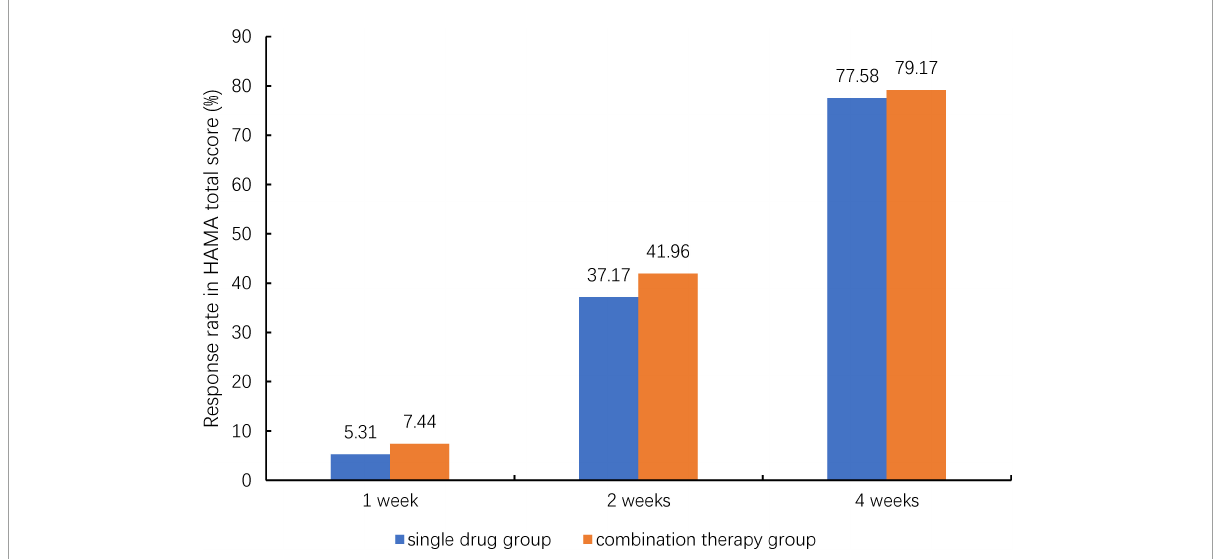
FIGURE2 Therapeutic response rate of patients with generalized anxiety disorder to Jiuwei Zhenxin granules alone (single drug group) or in combination with alprazolam (combination therapy group) at 4 weeks post-treatment. HAMA, Hamilton Anxiety Scale; TCM, traditional Chinese medicine. Response was defined as a 50% reduction from the baseline HAMA total score at 4 weeks post-treatment. And Chi-squared test was used for the comparison between the two treatment